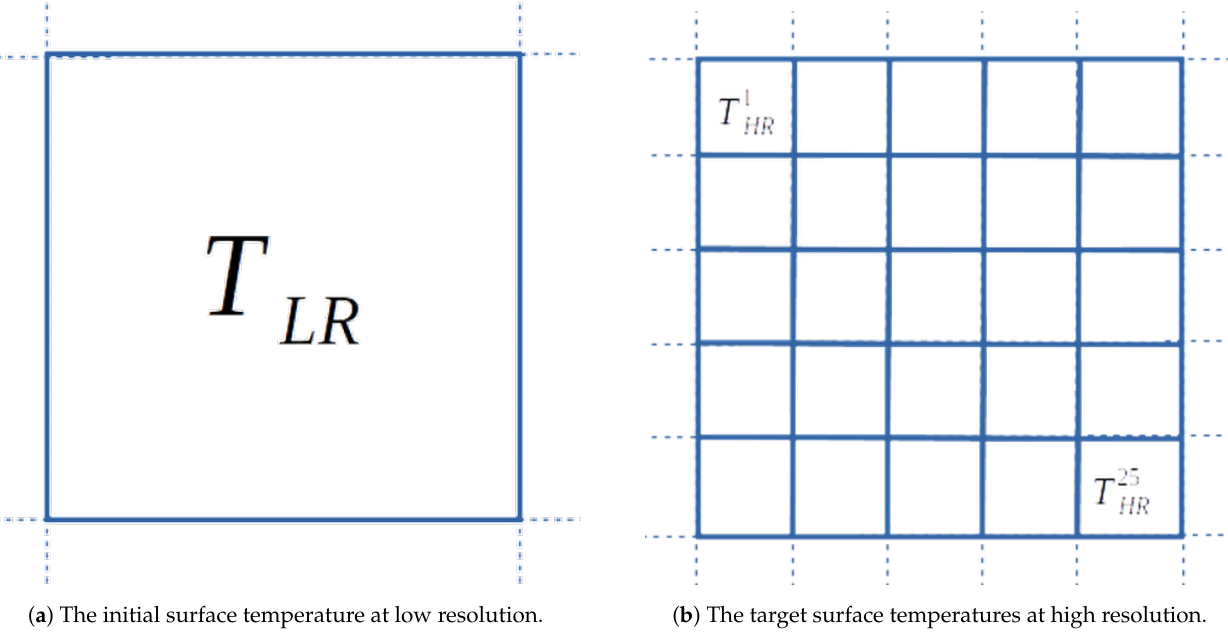
Figure 1. Schematic of the downscaling